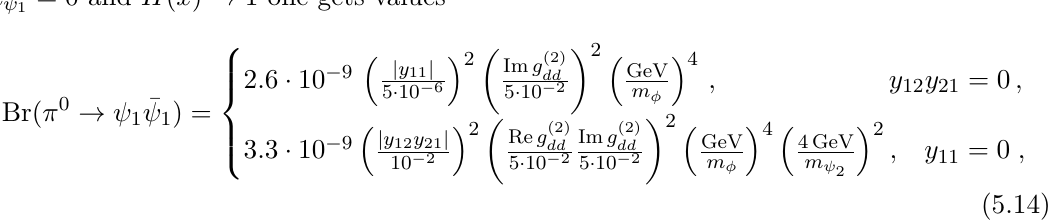
x ) 2 quoting H (0) = 1 and H (1) = 0 : 5 1)) = (1 (cid:0) (cid:0)